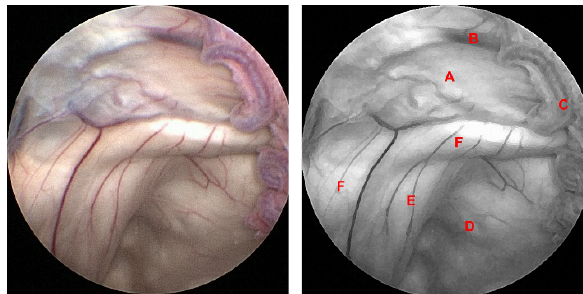
Fig. 12. Septum pellucidum (A), posterior septal vein (B), superior choroidal vein (C), collateral eminence (D), calcar avis (E), bulb of the occipital horn